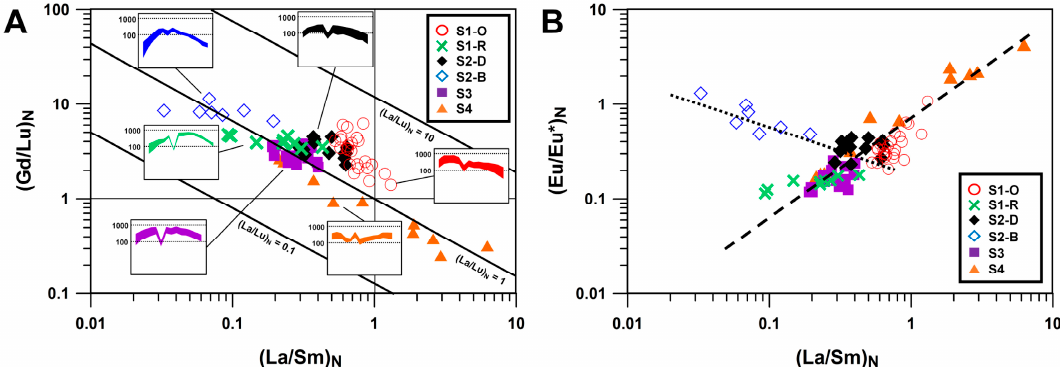
Figure 8. ( A ) Plot versus (Gd / Lu) N and (La / Sm) N . Isolines of (La / Lu) N are solid lines, calculated by assuming that Sm N and Gd N have approximately equal values. Most scheelites are plotted along the (La / Lu) N = 1 line, and S1-O plotted higher than the line represents LREE enrichment. ( B ) Plot versus (Eu / Eu*) N and (La / Sm) N . Eu* N is calculated as (Sm N × Gd N ) 1 / 2 . Eu anomaly shows linear trend in most scheelites and only S2-B shows di ff erent trend. This indicates that Sangdong scheelites were made by a single granitic body. Low REE content and weak Eu anomaly of S2-B can be evidence of meteoric mixing at the retrograde stage.